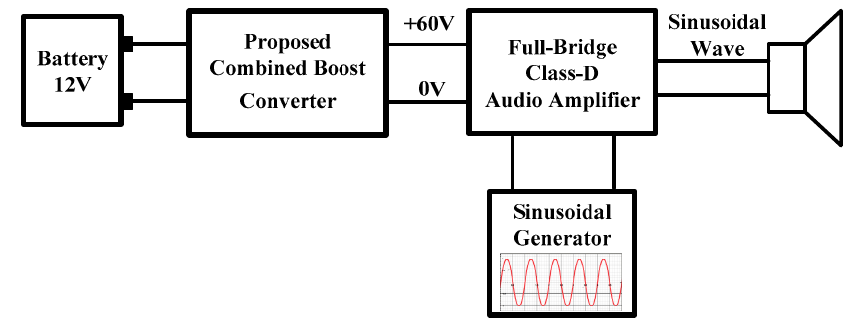
Figure 11. Block diagram of the experimental test setup.